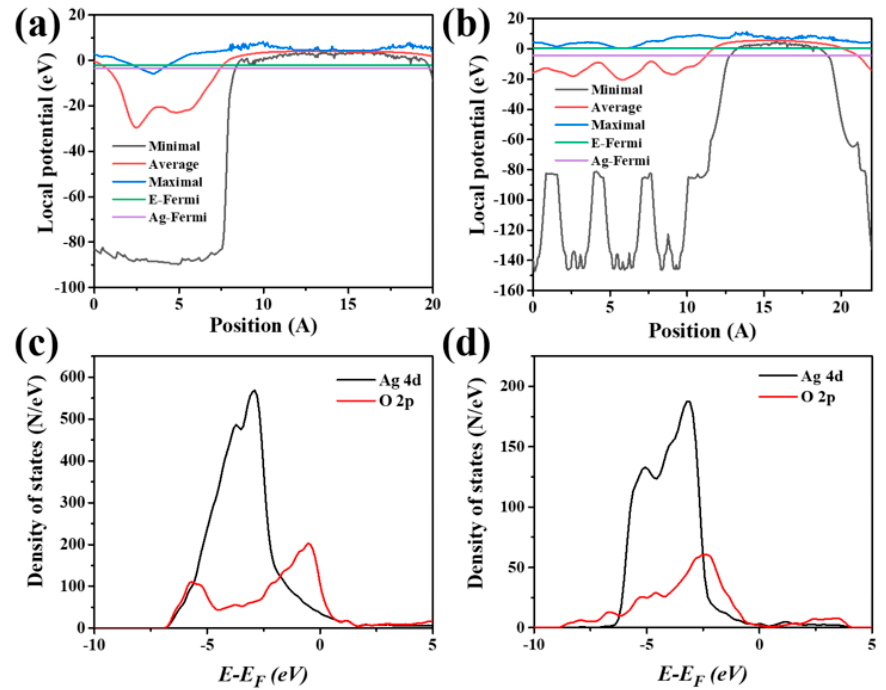
Figure 5. Calculations of the Fermi level difference between Ag and the reinforcing phases: ( a ) SnO 2 , ( b ) La 2 Sn 2 O 7 ; projected density of the state plots (pDOS) of the O 2p band and Ag 4d band for the Ag − SnO 2 interface ( c ) and the Ag − La 2 Sn 2 O 7 interface ( d ).